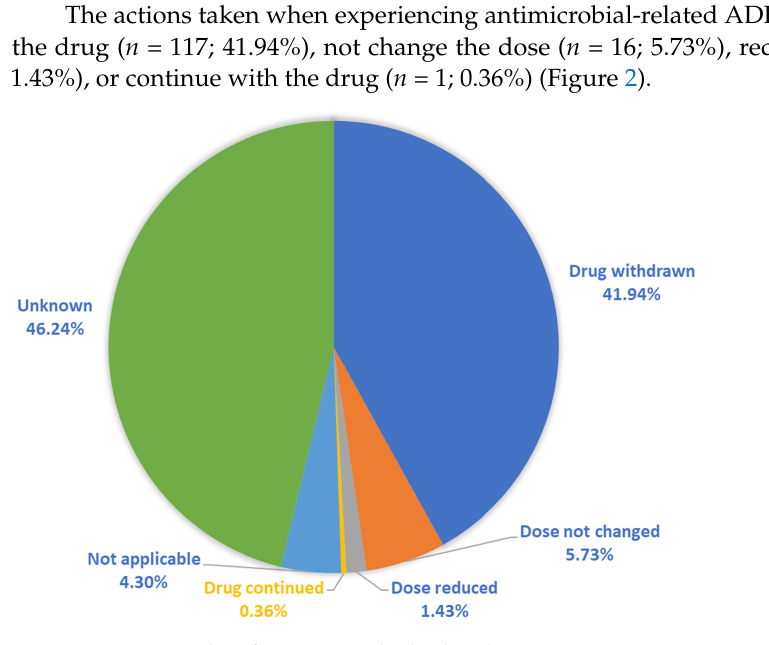
Table 4. Types of antimicrobial-related ADEs in individuals ( n = 279), according to the MedDRA system organ classi fi cation reported by the VigiBase in Jordan during 2003–2022.